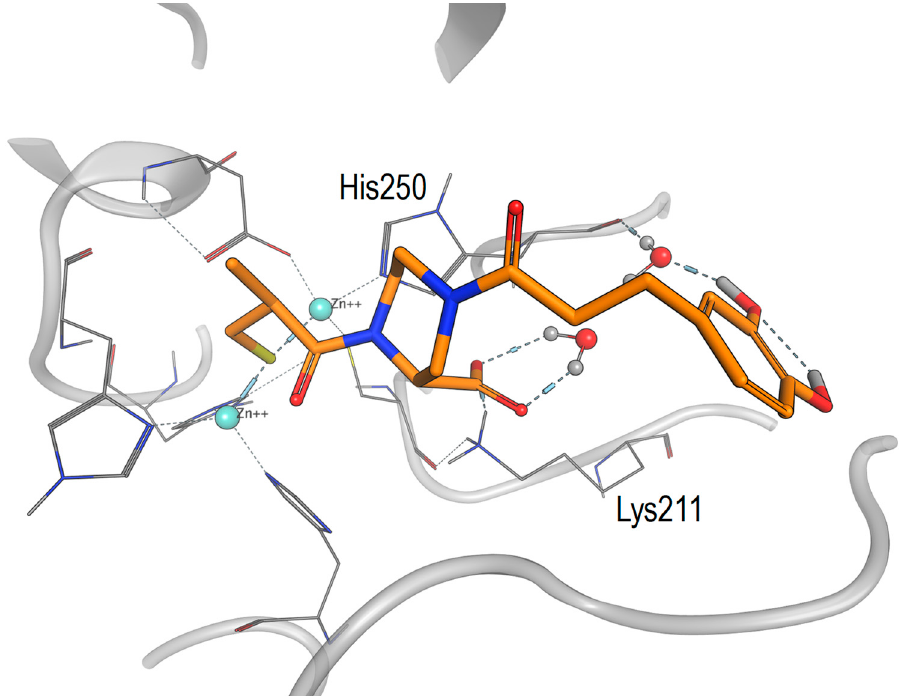
Figure 5. Proposed binding mode of compound 3 to NDM-1. Starting from the X-ray structure of compound 1 in complex with NDM-1 (PDB code 6LJ0), the catechol moiety was introduced manually and the complex was subsequently energy minimised.